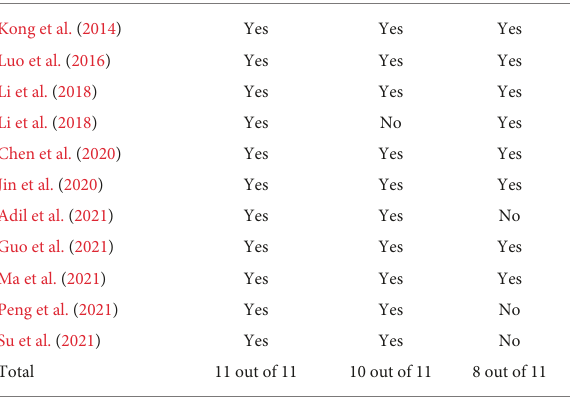
TABLE 3 Jackknife sensitivity analyses. All studies but . .. Right precuneus Left STG Right